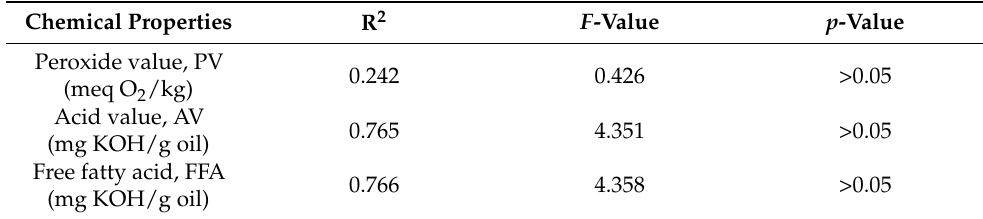
Table 7. One-way ANOVA analysis of the chemical properties of the extracted oil